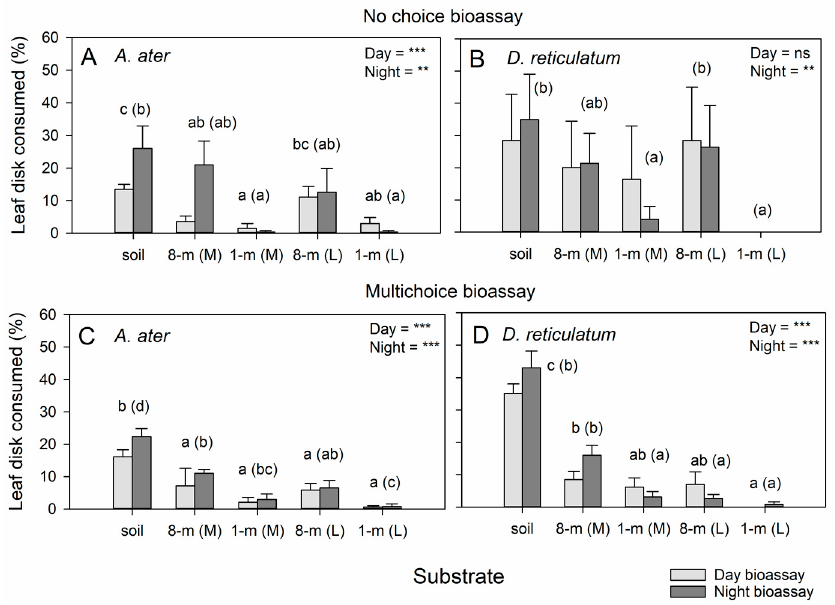
Figure 5. Results of no-choice ( A , B ) and multichoice ( C , D ) bioassays with A. ater ( A , C ) and D. reticulatum ( B , D ). Bioassays were conducted during daytime (light bars) and at nighttime (dark bars). Leaf disks (lettuce) were placed on substrates that included control (unamended) soil, 8-month-old SCG mixed (M) with soil or as a top layer (L) and 1-month-old SCG mixed with soil or as a top layer. Results from GLMs are presented for daytime (day) and nighttime (night) bioassays as ns = p > 0.05, ** = p < 0.01 and *** = p < 0.001 (N = 5 for no-choice, N = 6 for multichoice). Lowercase letters indicate homogenous substrate groups for daytime and nighttime (in parentheses) bioassays (Tukey, p > 0.05). Standard errors are indicated. (See also Table S2).